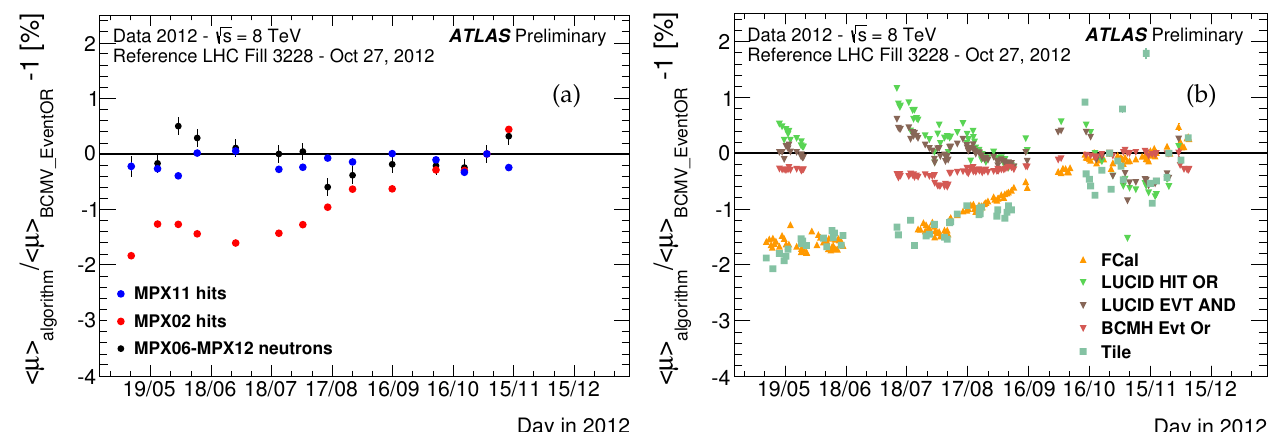
Figure 26. Fractional deviation in the number of interactions per bunch crossing (averaged over all colliding bunch pairs), obtained using ( a ) MPX results and ( b ) other ATLAS luminometers, with respect to the BCMV_EventOR value [21] and as a function of time in 2012. Each point shows the mean deviation for a single run compared to a reference run taken on 27 October 2012. Statistical uncertainties are shown per point, but in most cases are negligible. The MPX hit luminosity from a device that gives a constant ratio (MPX11) as well as that of a device with one of the largest increases (MPX02) are shown together with the luminosity measured with the MPX from thermal neutron counting averaged over MPX06 to MPX12. Taken from Ref.